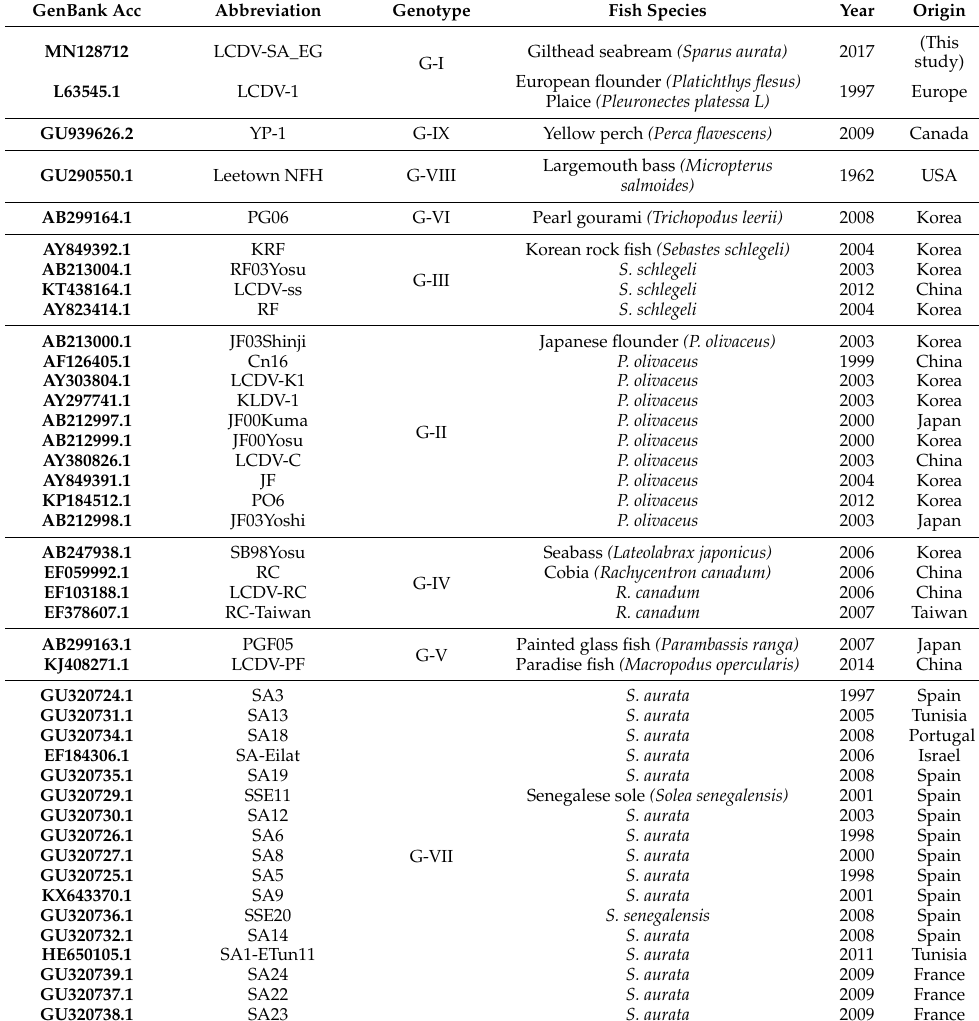
Table 1. Reference sequences used in phylogenetic